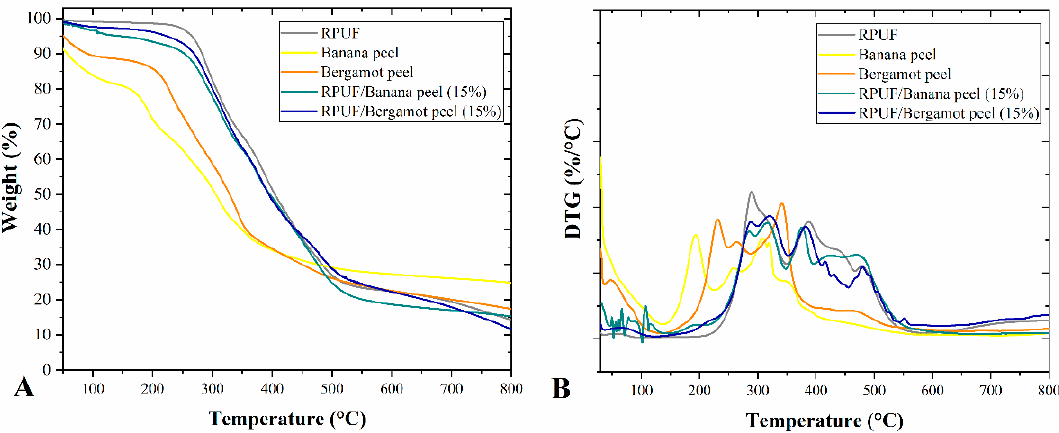
Figure 5. TG ( A ) and DTG ( B ) of the studied RPUF. Where: RPUF is the neat rigid polyurethane foam and filler type and filler content are the numbers after the bars and between parentheses, re- spectively. Table 2. Main thermal events evaluated by TG analysis of the studied RPUF.